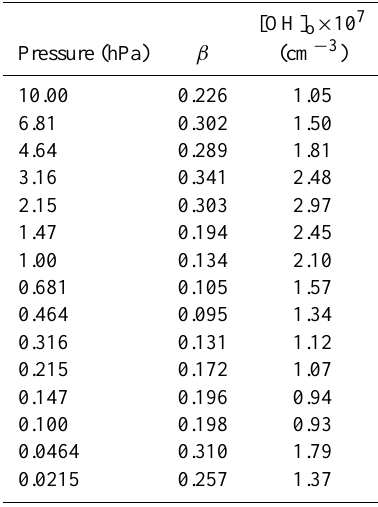
Table 1. Mean values of the OH-SZA fit parameters β and [OH] o from MLS measurements during the NH summers of